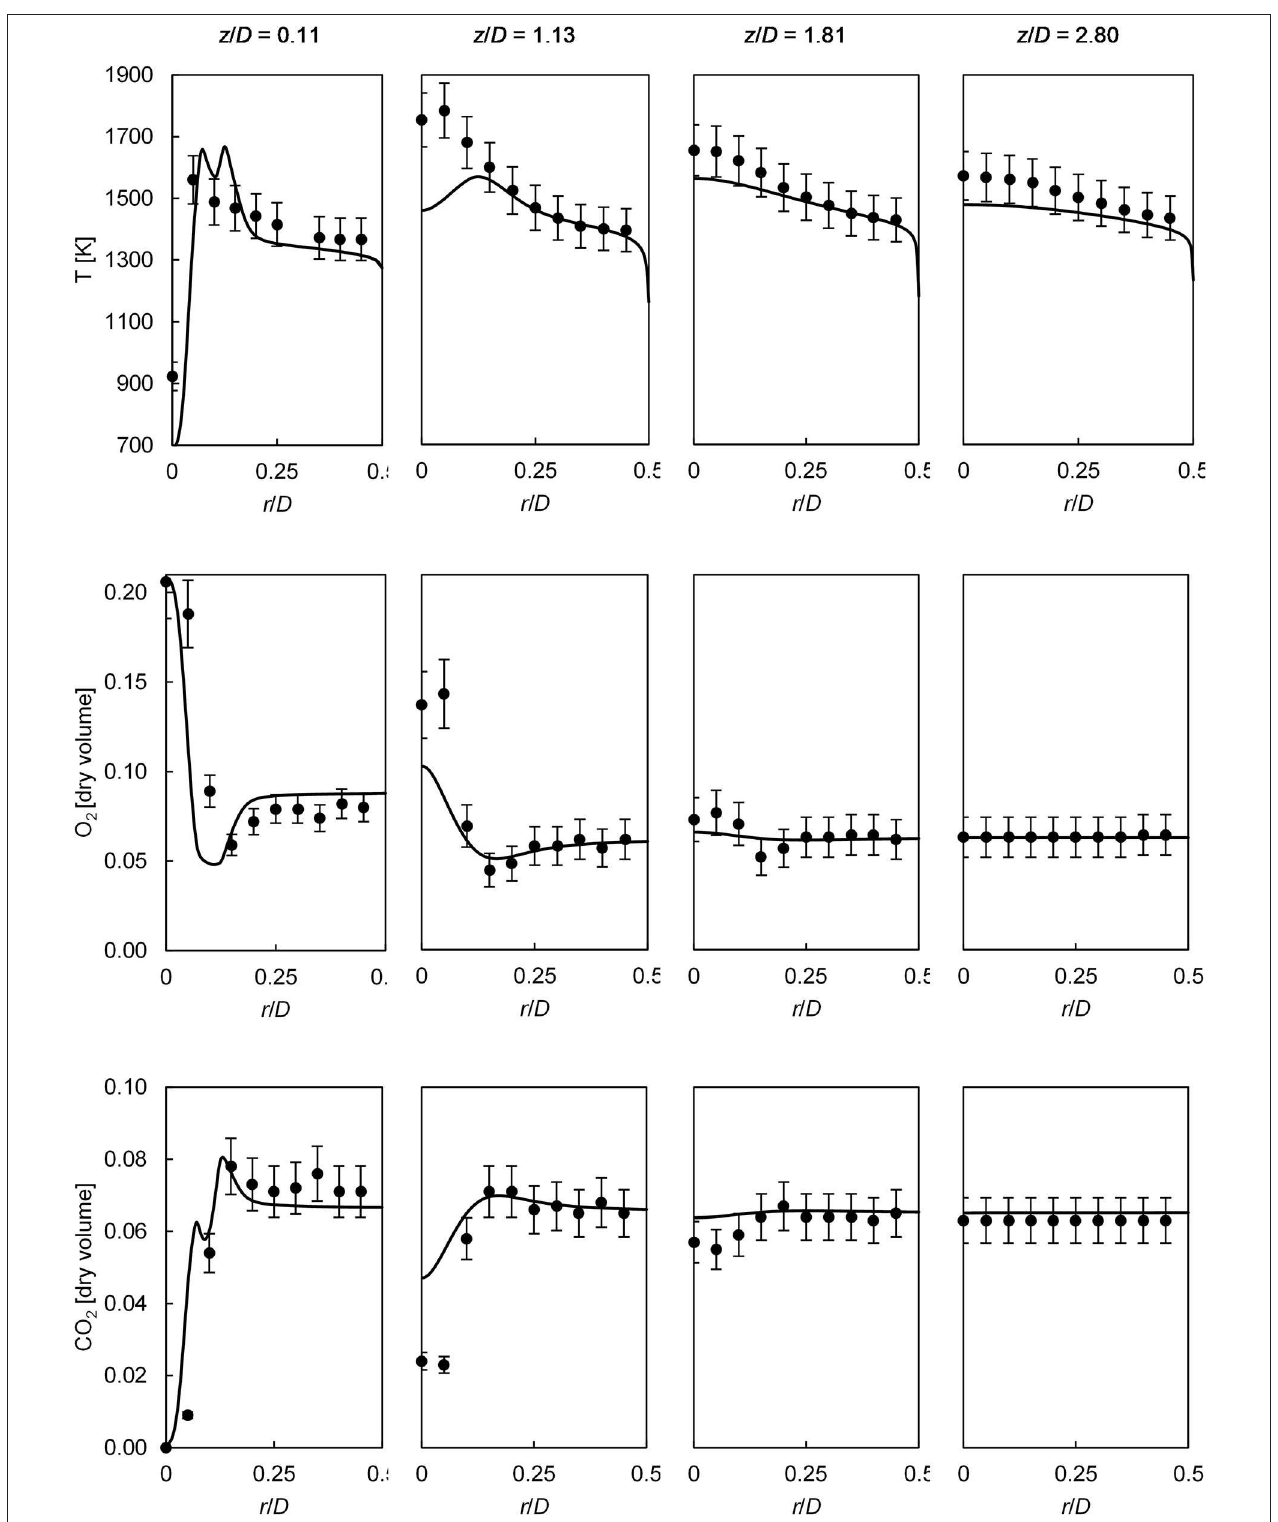
FIGURE 8 | Comparisons of experimental and CFD (FGM) parameters: temperature, O 2 concentration, and CO 2 concentration results along radial lines for condition d ( φ ∼= 0.59).